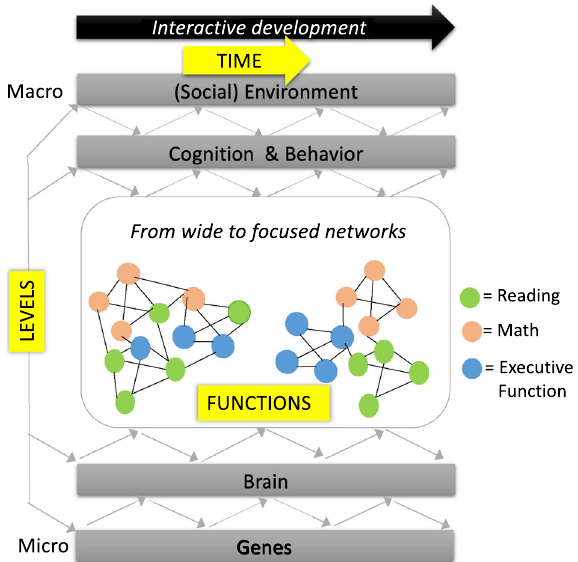
Fig. 1 Example framework that uni fi es developmental changes across levels and functions. During development (TIME dimension), there is continuous interaction across levels of change (LEVELS: gray bars) as well as across emerging functions (FUNCTIONS: presented as interactive networks). Reading, math, and executive function are chosen as examples of interactively emerging functions during development. Thus, during development, the neural and cognitive correlates of these different functions are fi rst characterized as wide, overlapping networks which then gradually specialize to more focused networks with learning and maturation (see section “ Bidirectional interaction across functional networks ”